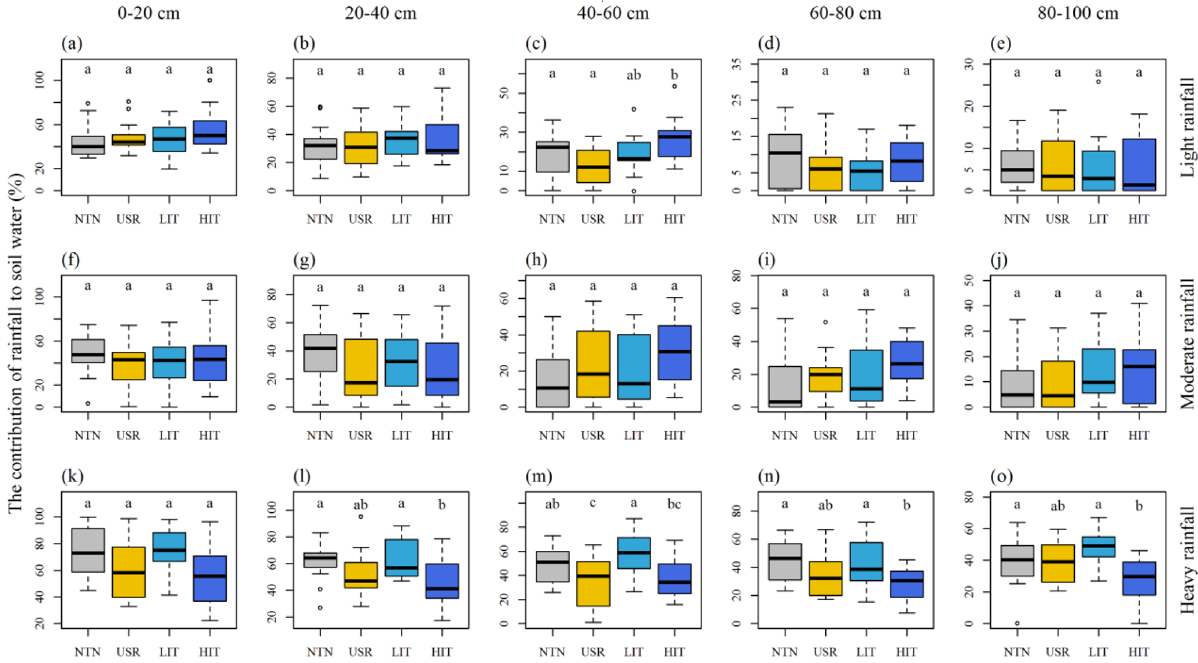
Figure 4. Contribution of light (a–e) , moderate (f–j) , and heavy (k–o) rainfall to soil water in five layers (0–20, 20–40, 40–60, 60–80, and 80–100 cm) with no thinning (NTN), understory removal (USR), light-intensity thinning (LIT) and heavy-intensity thinning (HIT) treatments. Different letters indicate significant differences at P < 0.05.